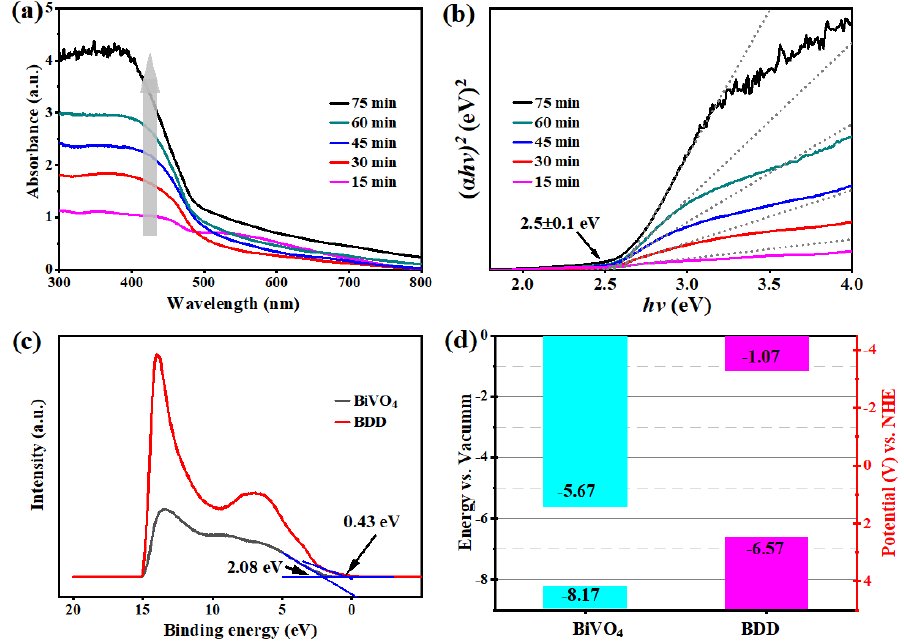
Figure 3. ( a ) The UV-VIS absorbance curves and ( b ) Tauc plots of the BiVO 4 films with different T d ; ( c ) UPS spectra for the BiVO 4 film and the BDD film; ( d ) Energy band positions of the BiVO 4 and the BDD in reference to vacuum level and NHE.